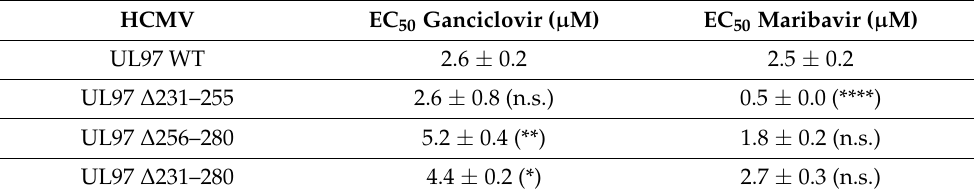
Figure 6. HCMV GFP-based antiviral assay was performed with the UL97 mutants in HCMV-infected HFFs (MOI of 0.25 GFP-FU/cell) to assess viral drug sensitivity ( A , B ). Mean values ± SEM of quadruplicate determinations are given (infections in duplicate, GFP measurements in duplicate). Table 2. EC 50 values that demonstrate the antiviral in vitro efficacy of ganciclovir and maribavir against recombinant HCMVs